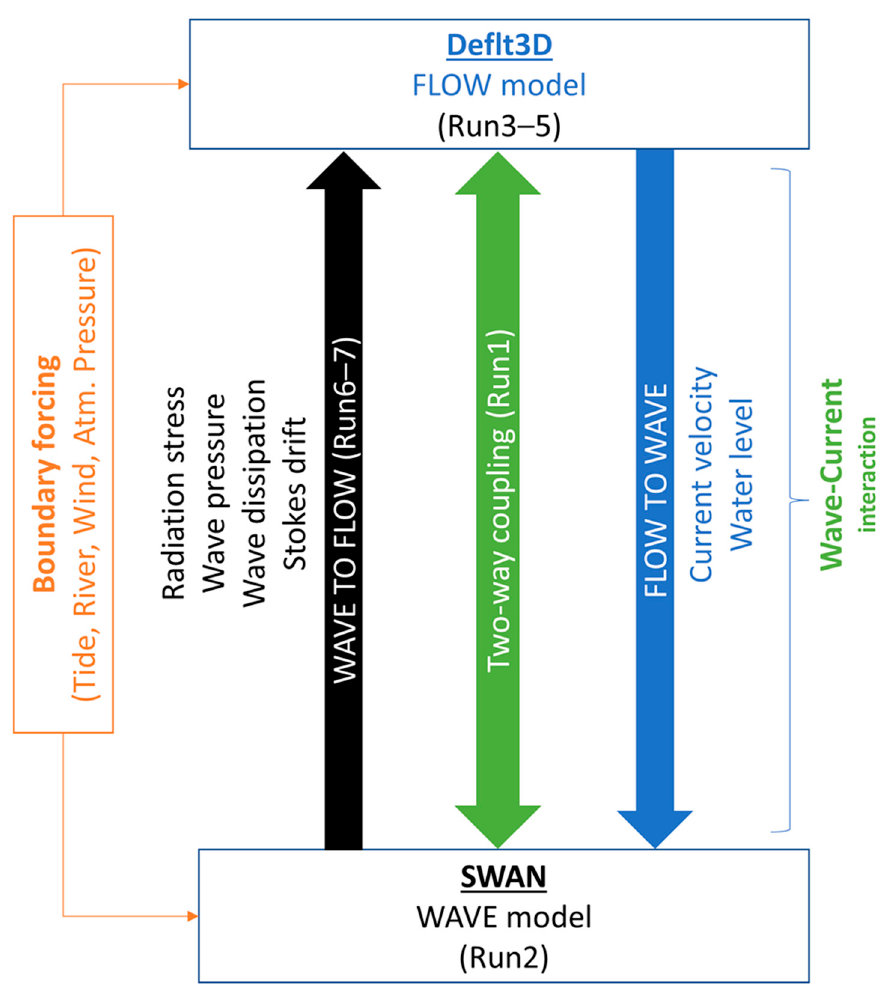
Figure 1. Flowchart of coupling between Deflt3D and SWAN. Different coupling procedures are applied to assess different processes in different scenarios, which are discussed in the result section.